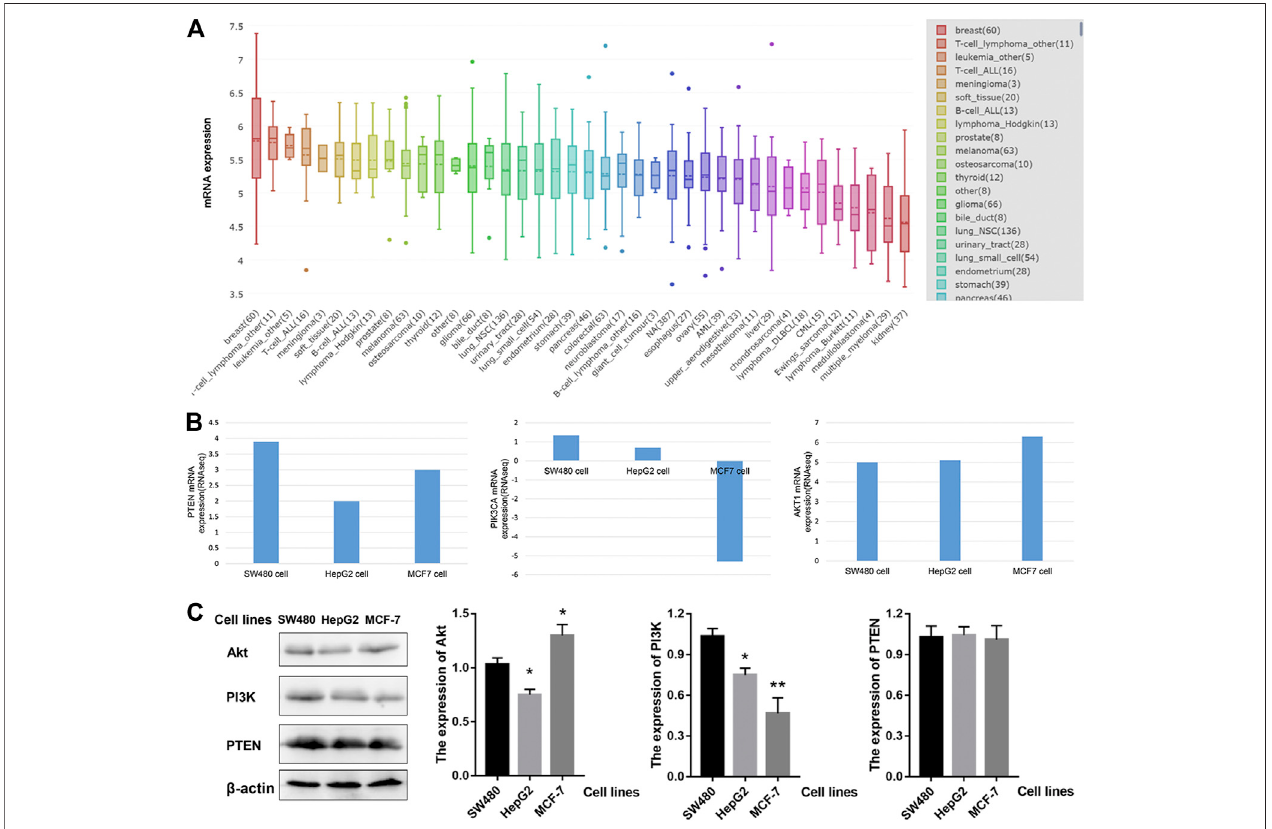
FIGURE4| TheexpressionofPTEN/PIK3A/AktmRNAlevelamongcancercelllines. (A) AKT1mRNAlevelindifferentcelllines. (B) TheexpressionofPTEN/PIK3A/ Akt in SW480, HepG2, and MCF-7 cells. (C) The protein expression levels of PI3K-Akt-PTEN in SW480, HepG2, and MCF-7 cell lines. * p < 0.05, ** p < 0.01 vs control group.